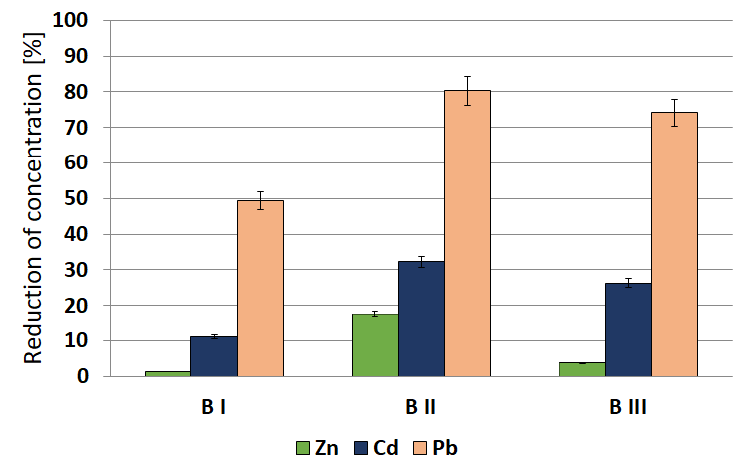
Figure 4. Reduction of concentration of Pb, Cd and Zn in soil samples treated with KH 2 PO 4.